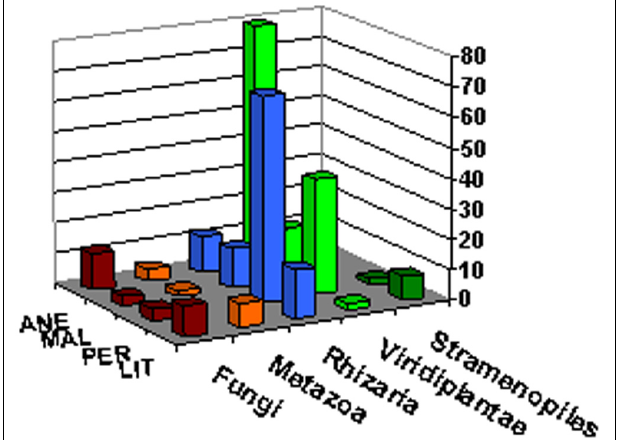
FIGURE 6 | Microbial eukaryotic diversity. Relative 18 rRNA abundance of major eukaryotic groups in gene libraries from ice samples.